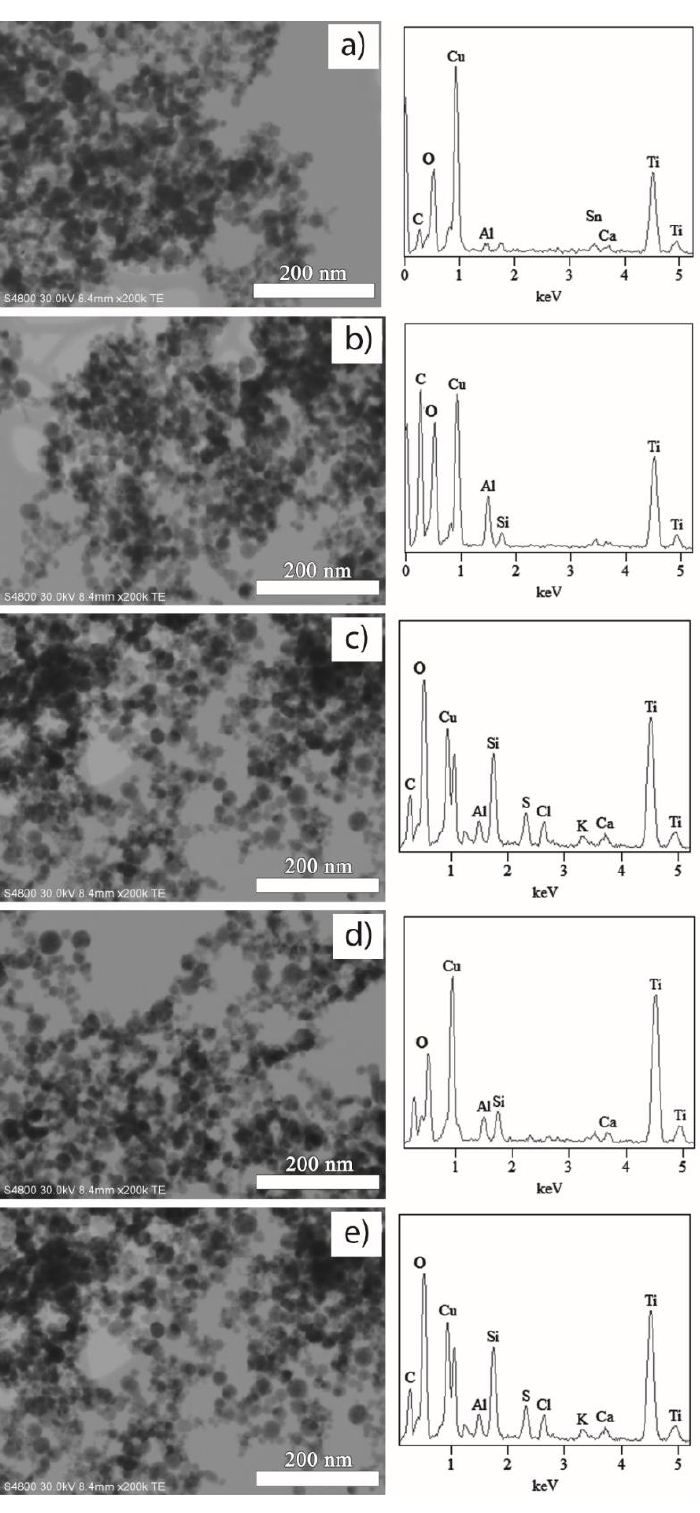
Figure 3. STEM images and EDS profiles of ( a ) TiO 2 100%, ( b ) TiO 2 /SiO 2 99.5/0.5, ( c ) TiO 2 /SiO